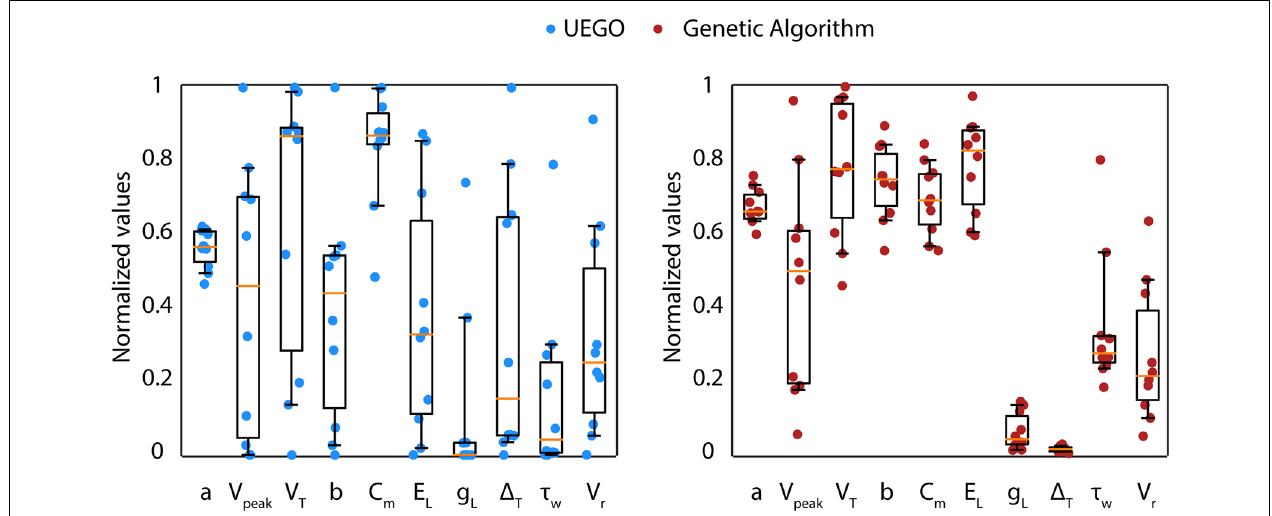
FIGURE 7 | Parameter distribution of candidate solutions from UEGO and GA. Comparison between the parameter values obtained from the best-ranked candidate solutions (from 1 to 10) in the execution of UEGO (left—blue circles) and from the best single solution of 10 independent executions of the GA (right—red circles). Each dot corresponds to the parameter value that defines every candidate solution. The boxes correspond to the IQR between the first (Q1) and the third (Q3) quartiles. The orange line represents the median among the values obtained for each parameter. The whiskers correspond to the 5- and 95- percentile respectively.